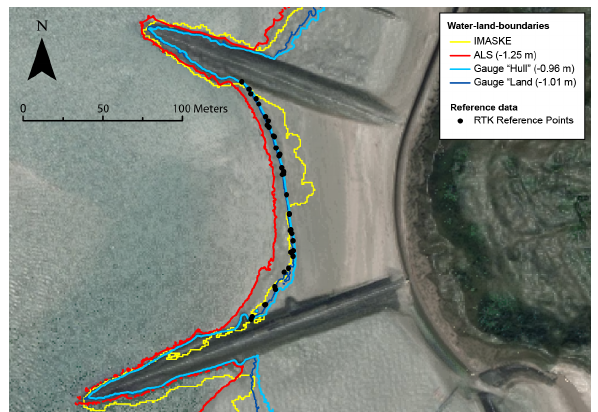
Figure 8. Photo of northern part of the GNSS survey site on Spiekeroog at the end of the F-SAR flight mission. Direction of Figure 6. Study site with underlying ALS DEM, GNSS view towards south. Note the surface water and water saturated reference points and the evaluated WLB approximations. The patches in the left center. location of the study site on Spiekeroog island is indicated in Figure 2. other supplementary data sets from additional surveying meth- ods, especially the WLB on base of the IMASKE is of import- ance here.